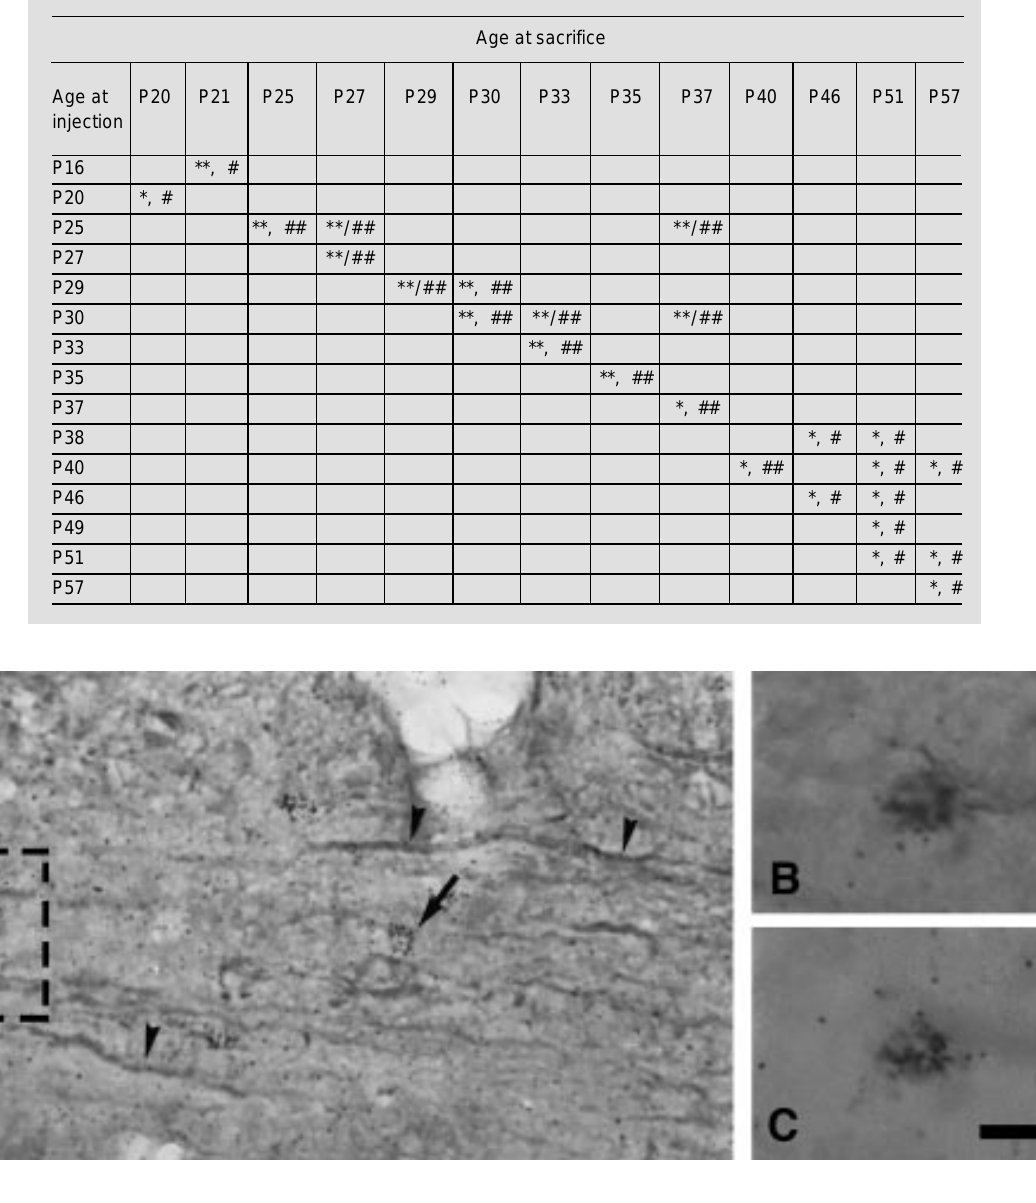
Figure 3 - Proliferation of interfascicular, CNPase+ and CNPase- cells. Parasagittal section through the medial longitudinal fascicle containing the pons- medulla transition in a P27 opossum that received a single intraperitoneal [ 3 H]-T injection (10 µCi/g body weight) and was killed 2 h later. Immunoreaction with an anti-CNPase polyclonal antibody using the biotin-avidin-HRP method (Sigma kit) followed by radioautography as in Figure 1A. A, Panoramic view to show CNPase+ fiber sheaths (arrowheads) with interspersed radiolabeled [ 3 H]-T+ cells, one of which is within a box of interrupted lines and shown at higher magnification and at two focal depths in B and C. The arrow points at a CNPase-/[ 3 H]-T+ cell. B, Boxed area in A with focus on the immunohistochemical product. C, The same area with focus on the silver grains. Magnification bar: A = 25 µm; B and C =